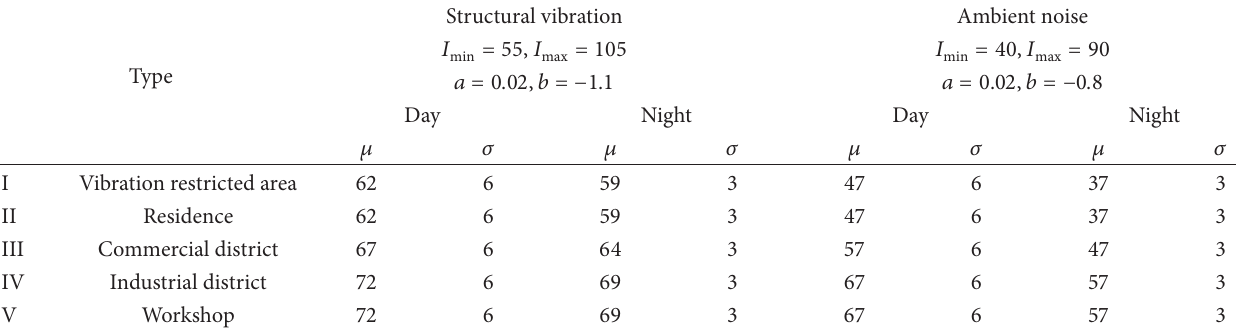
Table 1: Reference values of parameters for annoyance degree calculation of typical